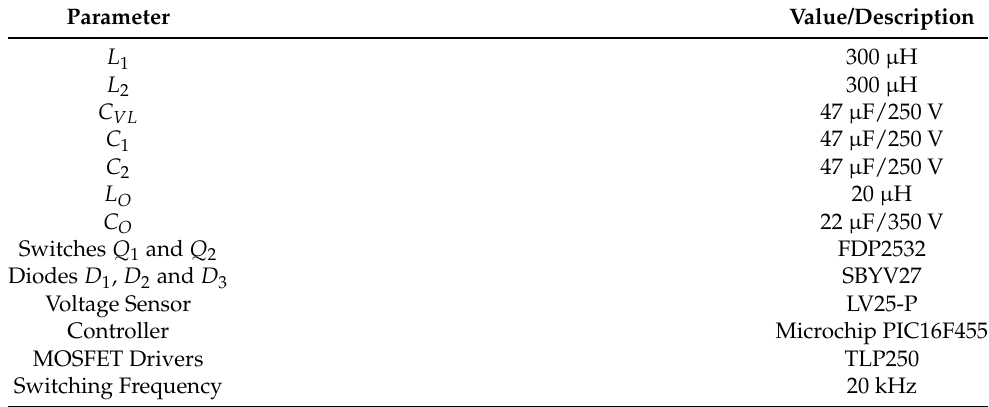
Table 1. Prototype details.